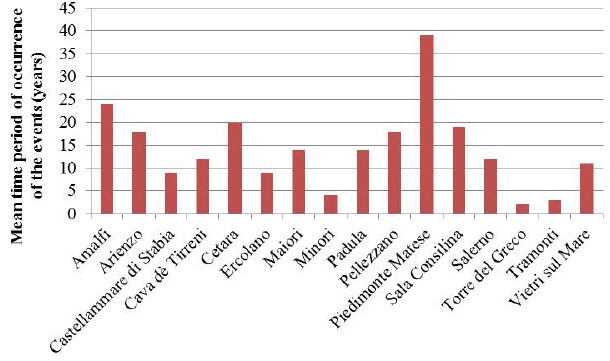
Figure 8. Mean time period of occurrence of the events in the mu- nicipalities that have recorded more than 10 events.